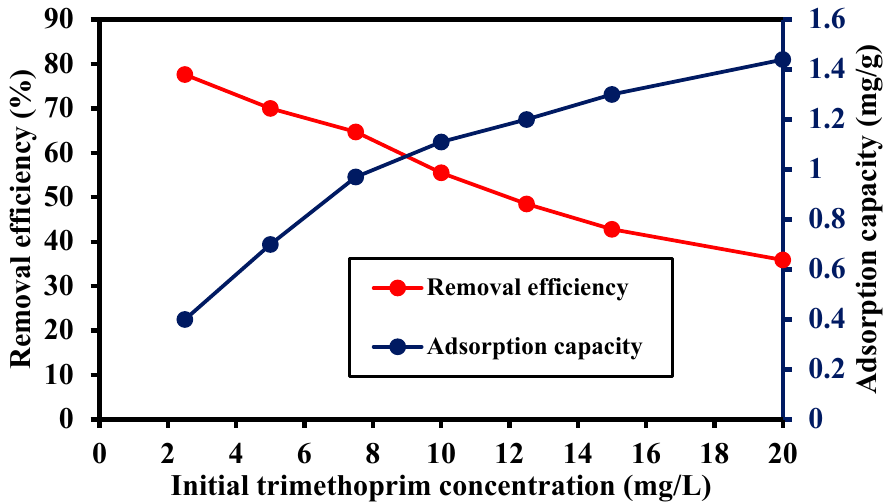
Figure 8. Effect of initial trimethoprim concentration on the removal efficiency of trimethoprim antibiotic and the adsorption capacity of Bio-MOF, pH of 7, contact time of 60 min, and adsorbent dose of 0.5 g/L.